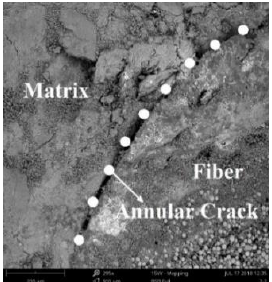
Figure 11. Annular crack in TRC.